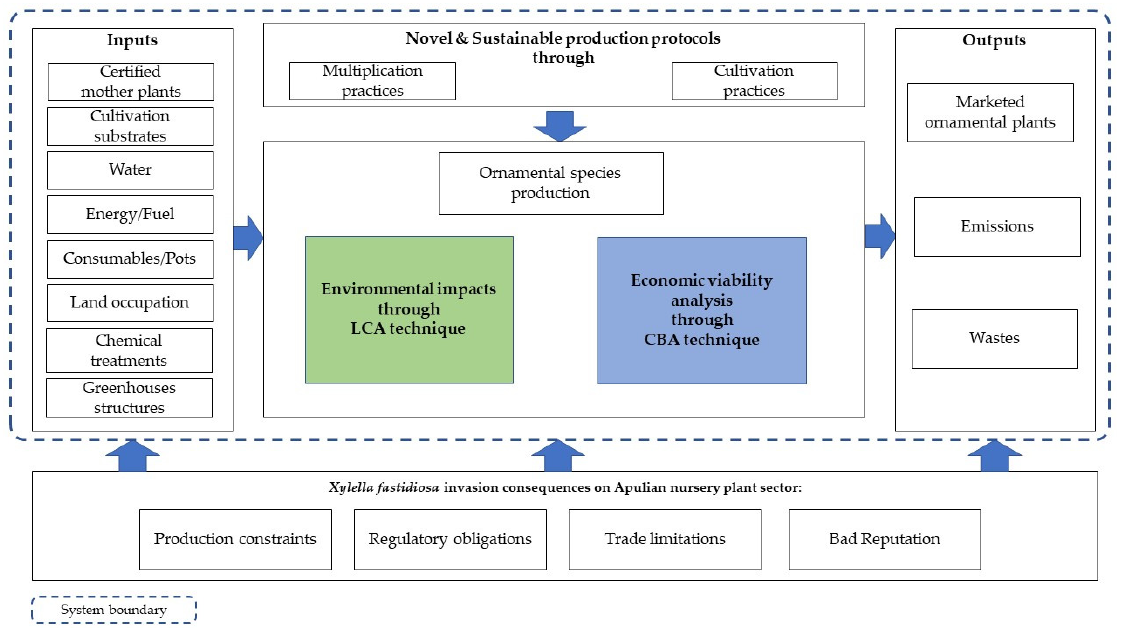
Figure 1. Overview of the categories of inputs and outputs that were considered in our ornamental production assessment. The diagram also highlights the main consequences of Xylella fastidiosa invasion on the nursery sector in Apulia region (Southern Italy).